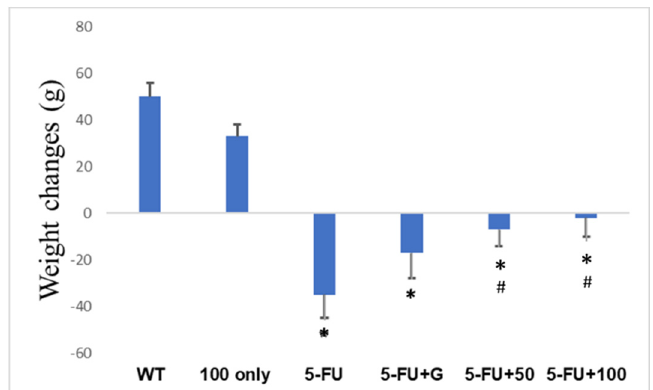
Figure 2. The body weight changes (before and after treatment) in six experimental rat groups.